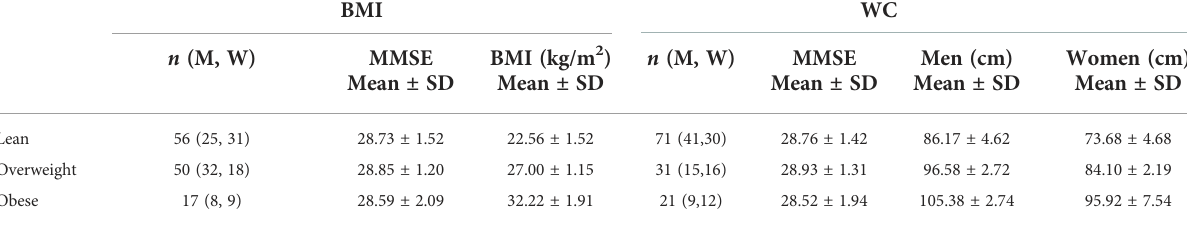
TABLE 4 Demographic characteristics of each group strati fi ed using the established body mass index (BMI) cutoff points for lean participants (BMI < 25), overweight participants (25 ≤ BMI < 30), and participants with obesity (BMI ≥ 30) or using the established waist circumference (WC) cutoff points for lean participants (WC < 94 cm for men and WC < 80 cm for women), overweight participants (94 ≤ WC < 102 for men and 80 ≤ WC < 88 for women), and participants with obesity (WC ≥ 102 for men and WC ≥ 88 for women).